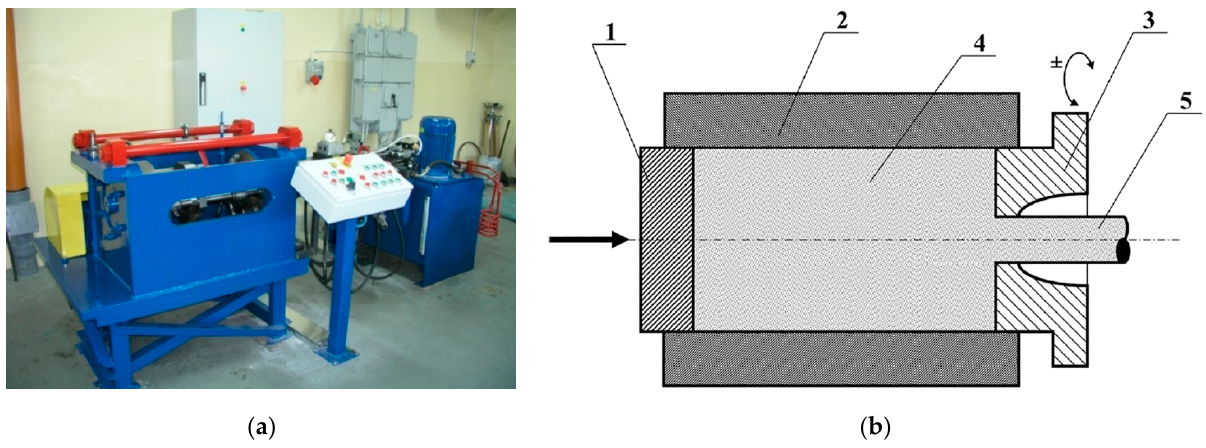
Figure 2. The Kobo hydraulic extrusion press for extruding metals and alloys: ( a ) general view; ( b ) principle of operation 1 = punch, 2 = container, 3 = a die rotating on both sides, 4 = starting material, 5 = final product ( a ) is reprinted with permission from ref. [28]. Copyright 2016 Polish Academy of Sciences. ( b ) is reprinted with permission from ref. [31]. Copyright 2013 Ł ukasiewicz Research Network–Metal Forming Institute.)